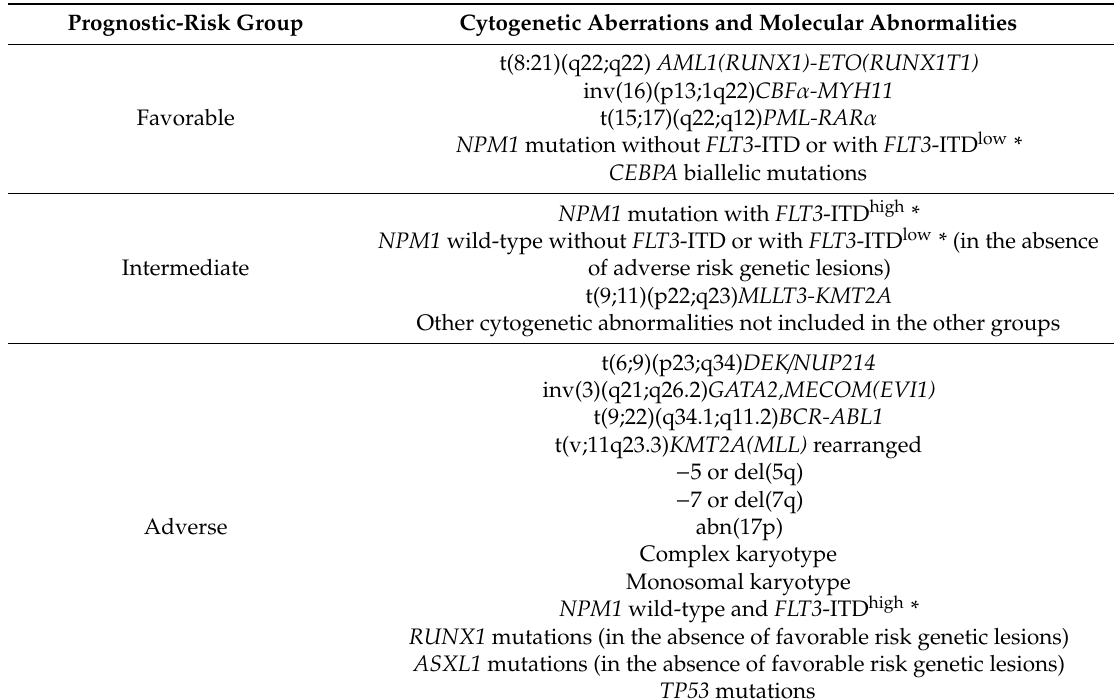
Table 1. Cytogenetic and molecular profile of prognostic-risk